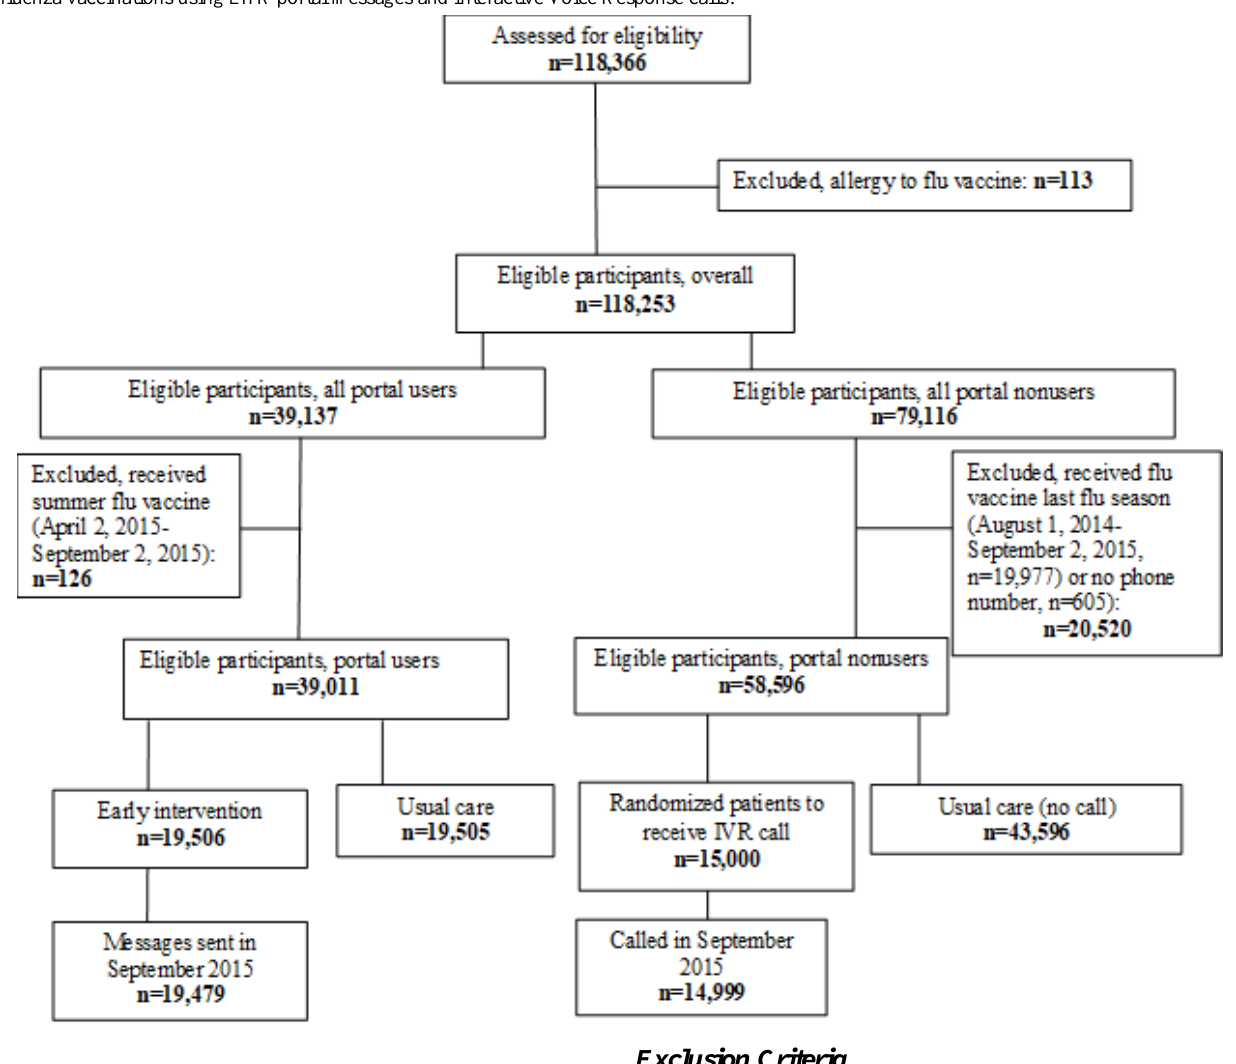
Figure 1. CONSORT (Consolidated Standards of Reporting Trials) Diagram describing randomized controlled trial to improve rates of early season influenza vaccinations using EHR portal messages and Interactive Voice Response